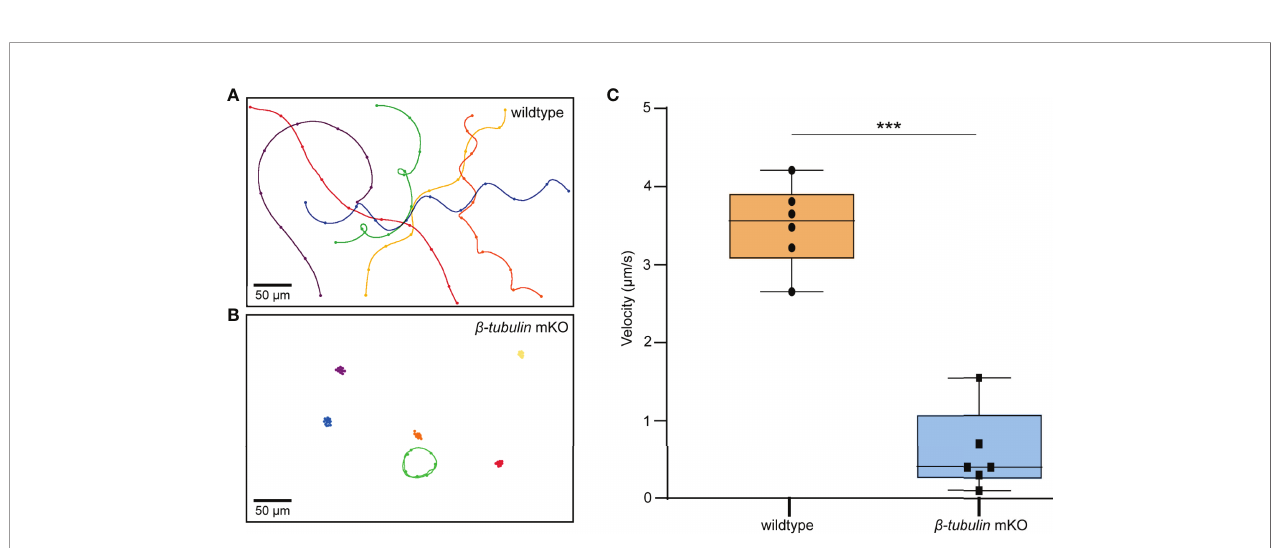
FIGURE 7 | Motility assay in C . gigas angulate G 0 larvae. Swimming trajectories of larvae (8 hpf) by electroporation with sgRNA/Cas9 complex (B) or not (A) . Original microscopy videos are provided in Supplementary Video 2 (electroporation with sgRNA/Cas9 complex) and Supplementary Video 1 (electroporation without sgRNA/Cas9 complex). (C) t -test shows the signi fi cantly reduced larvae swimming velocity in the electroporation group with sgRNAs/Cas9 complex ( p < 0.001, three